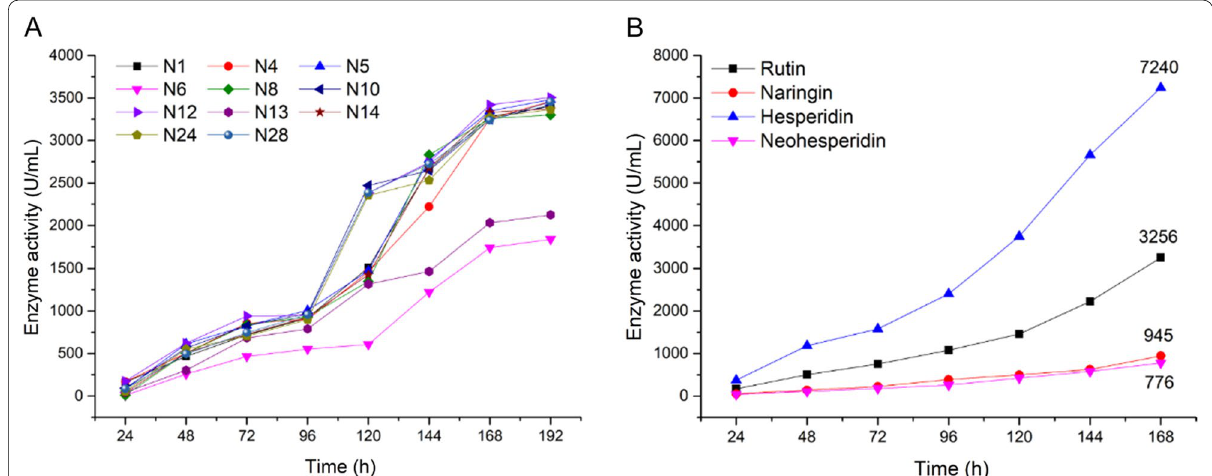
Fig. 1 A Enzyme activity of α-L-rhamnosidase produced by 11 engineered strains (rutin as substrate). B The difference in enzyme activity of N12-Rha on different